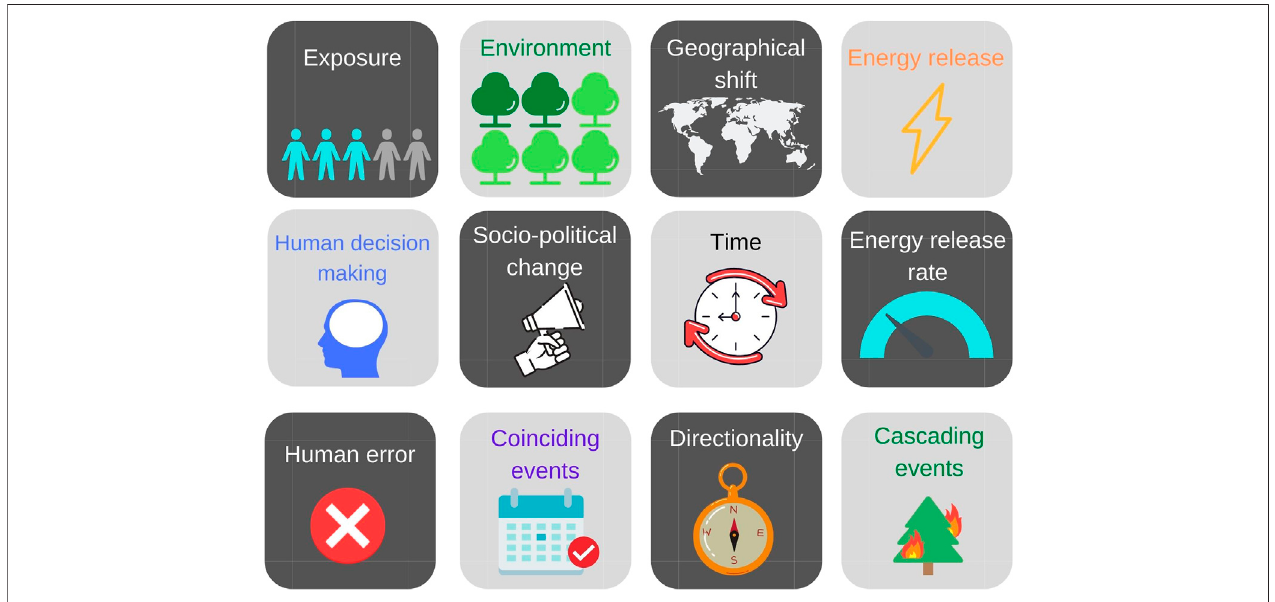
FIGURE 3 | Turn types proposed by Lin et al. (2020) (with “ directionality ” added). This fi gure was given to the participants as a suggestion for the types of possible turns (Supplementary Document S1) , and indicates the turn types used for deductive coding (Section 2) .